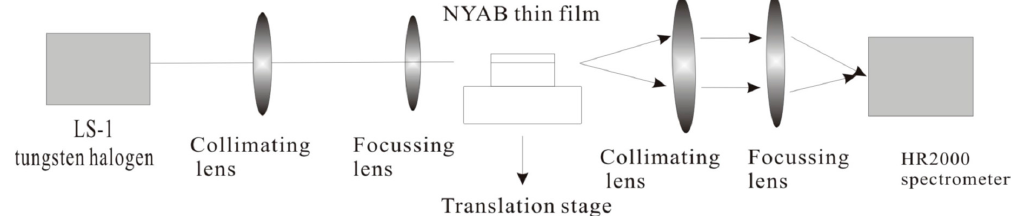
Figure 6. Experimental setup for measuring absorption spectra along guiding direction.